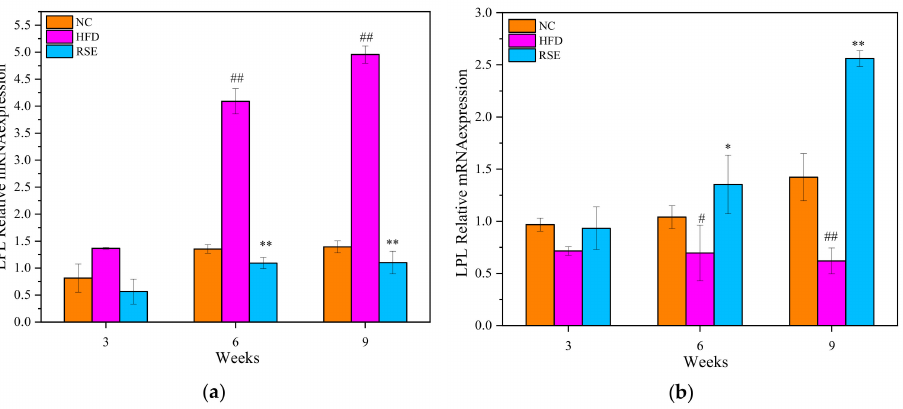
Figure 5. Effects of RSE on the LPL relative mRNA expression in epididymal adipose tissue ( a ) and skeletal muscle ( b ). Data are expressed as the mean ± SEM. # p < 0.05 and ## p < 0.01 for NC vs. HFD; * p < 0.05 and ** p < 0.01 for RSE vs. HFD. Group abbreviations: refer to Figure 2